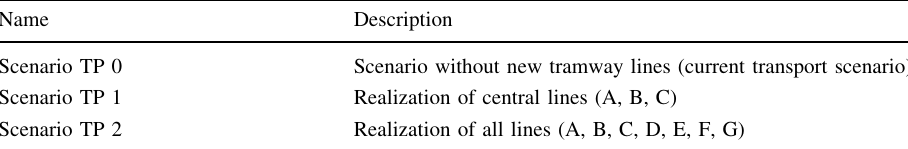
Table 8 Scenarios taken into account for the economic and financial statement